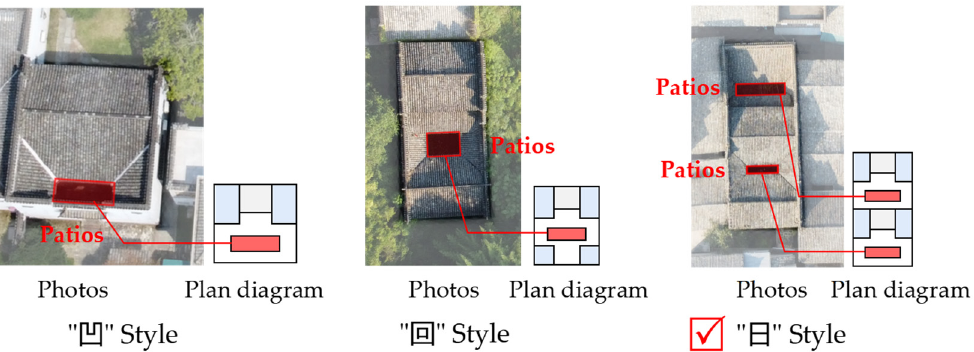
Figure 3. Three typical floor plans of traditional houses in Xixinan Village (The ” 凹 ”, ” 回 ” and ” 日 ” represent the building